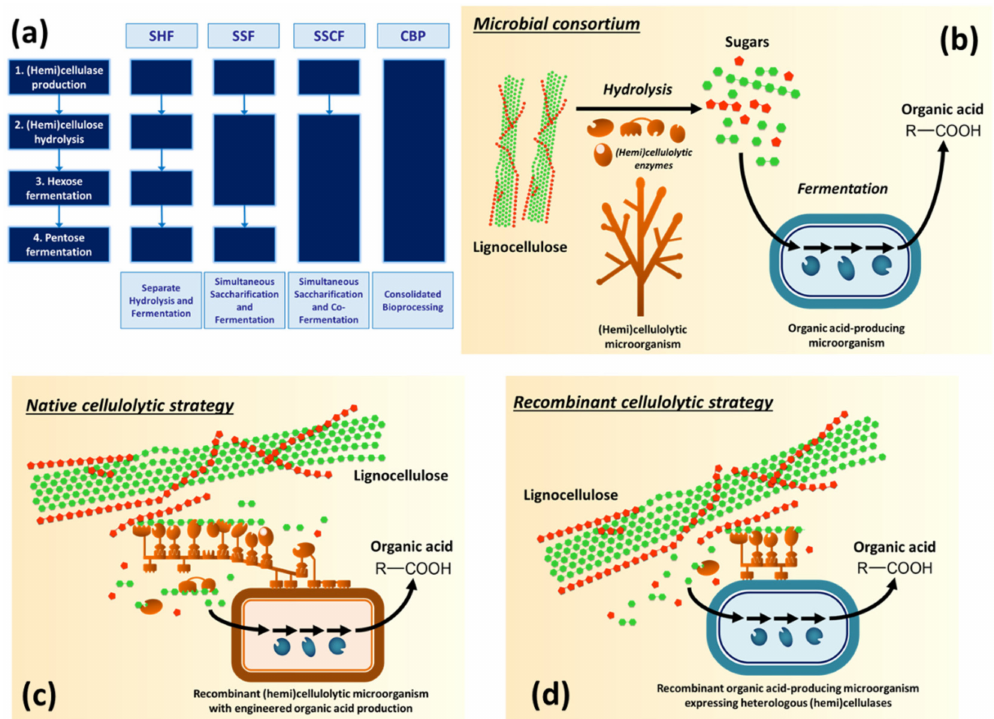
Figure 1. Paths towards consolidated bioprocessing (CBP) of lignocellulosic feedstocks to organic acids. ( a ) Fermentation of lignocellulosic biomass involves four biological events (production of hemi/cellulolytic enzymes, biomass saccharification, hexose and pentose fermentation). In SHF (separate hydrolysis and fermentation) configuration, each event occurs in a dedicated bioreactor, while CBP features a single fermenter in which all biological events are performed. CBP can be developed through consortia of (hemi)cellulolytic (brown) and organic acid-producing (blue) microorganisms ( b ), by metabolic engineering of a native (hemi)cellulolytic microorganism with organic acid-producing pathway (native cellulolytic strategy) ( c ), or by an efficient organic acid-producing microorganism engineered with a heterologous (hemi)cellulase system (recombinant cellulolytic strategy) ( d